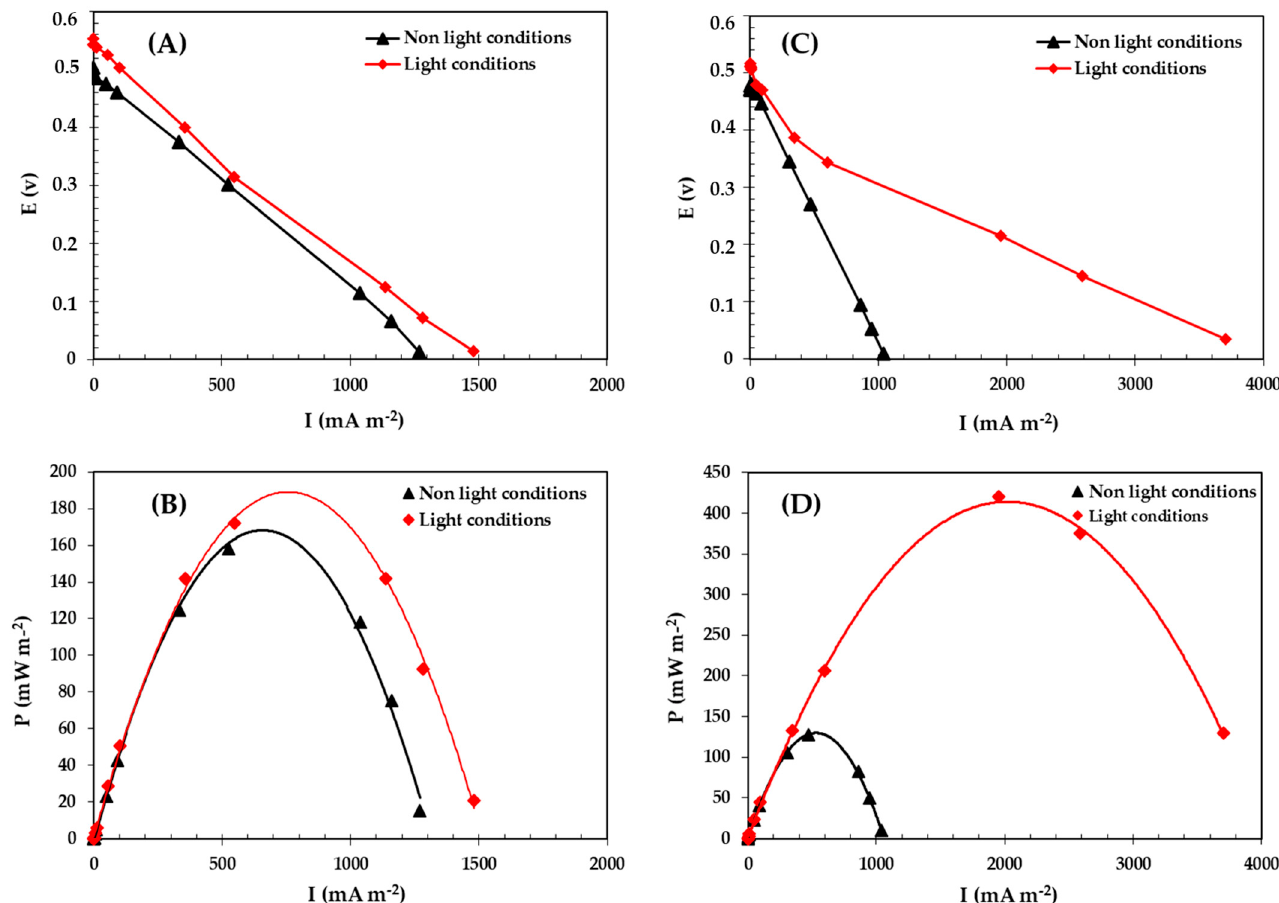
Figure 8. Polarization and power density curves of air-cathode MFCs: Cs 5 PMo 11 FeO 39 ( A , B ) and Cs 5 PMo 11 CoO 39 ( C , D ). Table 3. Performance of MFCs equipped with polyoxometalate salts cathode in the presence and absence of light.